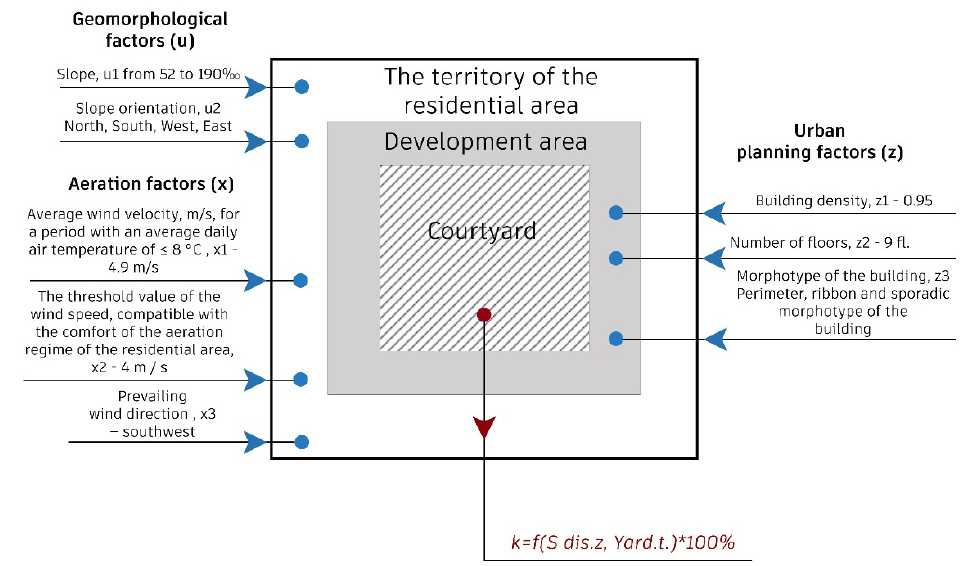
Figure 8. Theoretical model of the aeration regime of the residential development on the sloping lands of the Arctic zone of the Russian Federation with boundary conditions for modeling purposes. The output parameter of the theoretical model will be Y, the area of discomfortable zones. Parameter Y is a function in which arguments include all factors x, u, and z listed